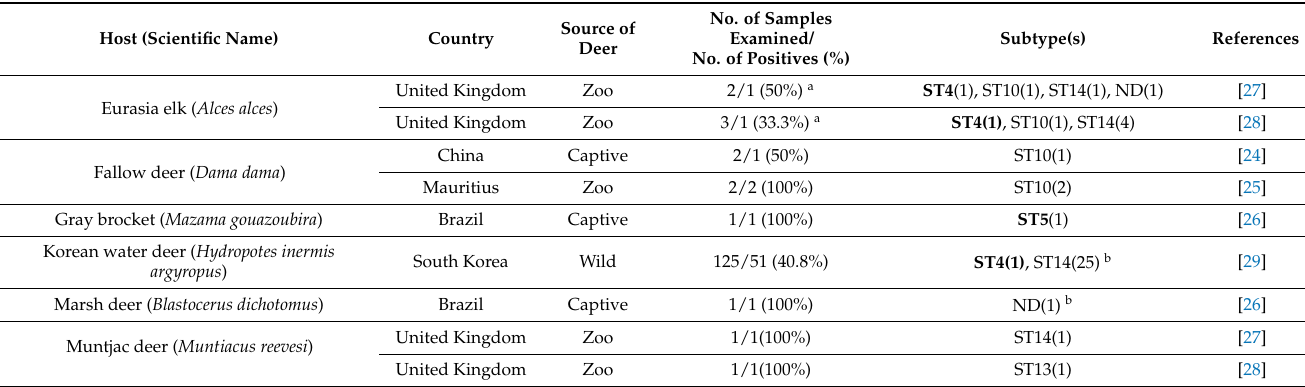
Table 1. Summary of studies reporting prevalence and subtypes of Blastocystis identified in deer. Potentially zoonotic subtypes are in